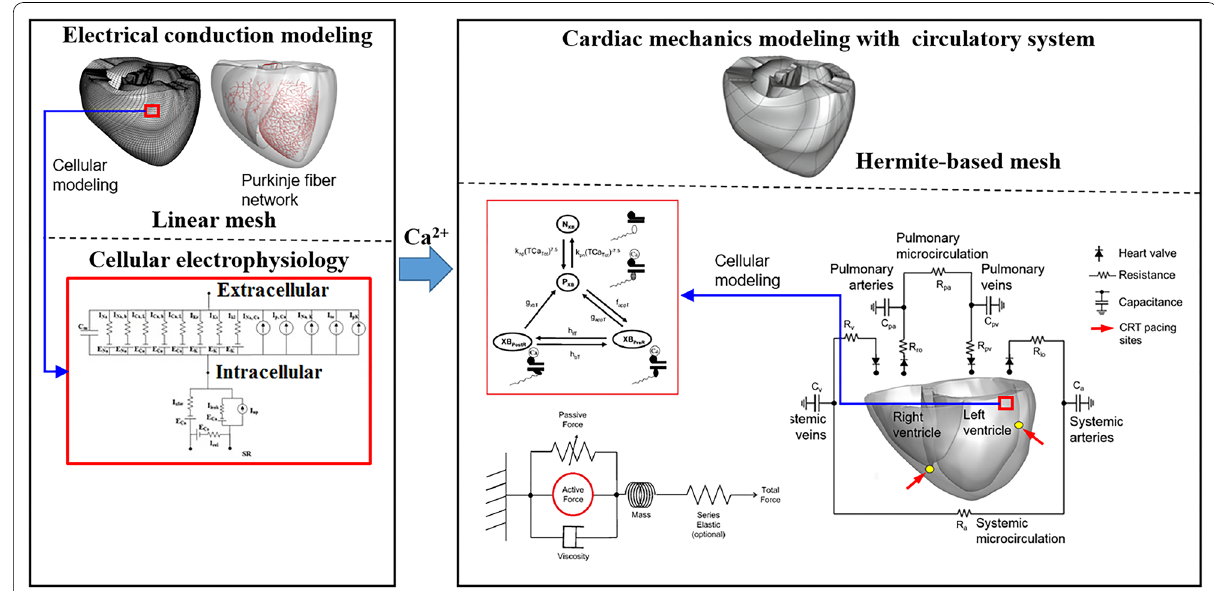
Fig. 2 The schema of the cardiac electromechanical model. Here, the cellular excitation–contraction is incorporated into the tissue mechanical model and vascular hemodynamics implemented in the lumped parameter model interacting with cardiac electromechanical contraction. C a systemic artery compliance, C pa pulmonary artery compliance, C pv = = therapy, C v systemic vein compliance, R a systemic artery resistance, R lo = = R pv pulmonary vein resistance, R v systemic vein = =